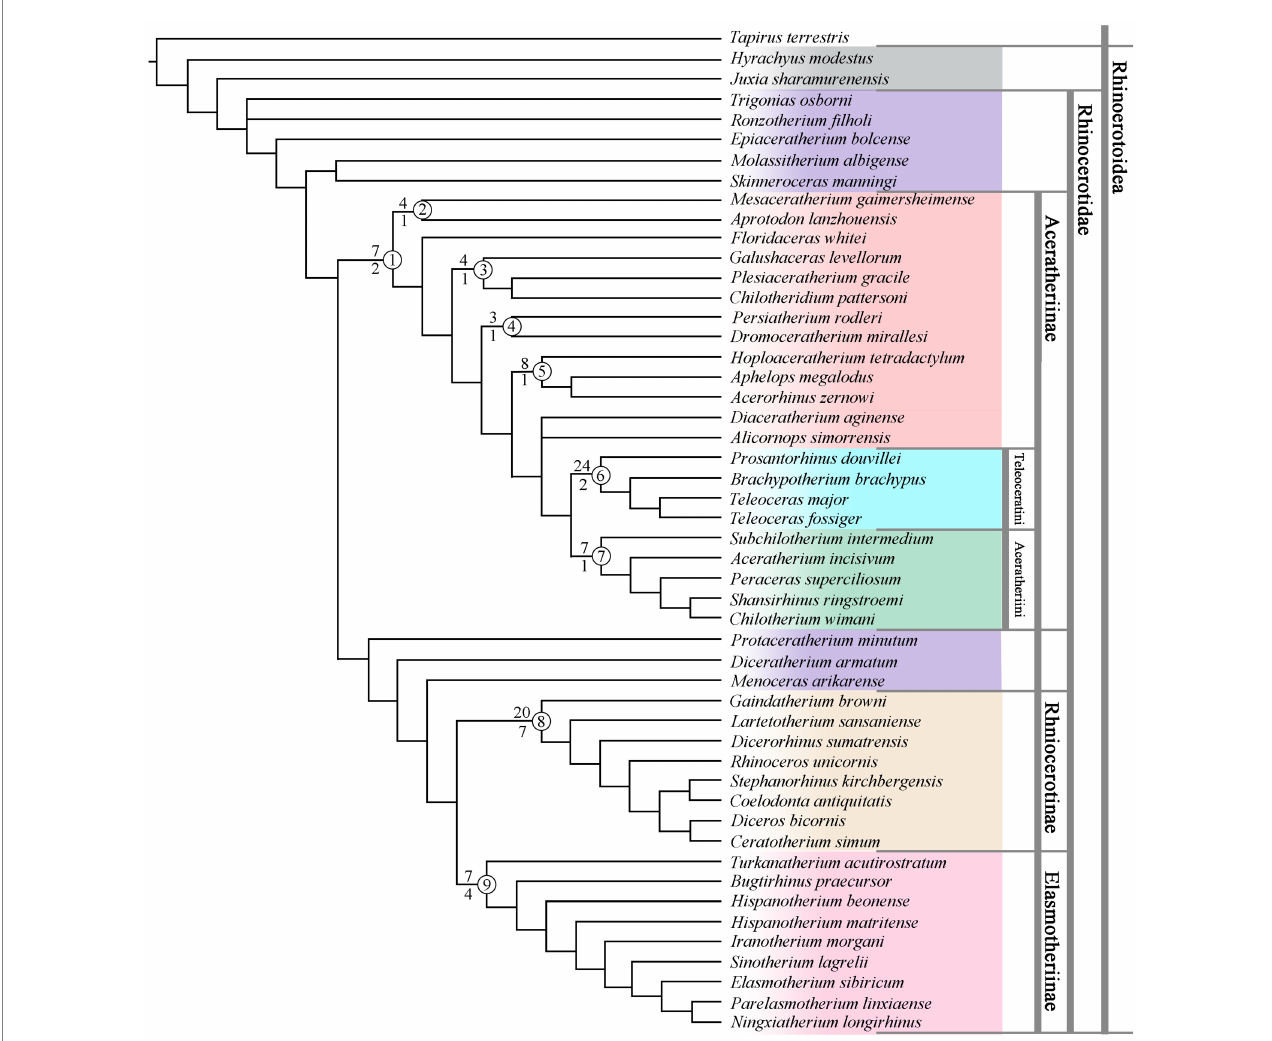
FIGURE 1 Consensus tree of the three most parsimonious trees with 98 characters ordered. Numbers above nodes are counts of synapomorphies and below nodes are Bremer support values. Colored areas and labeled thick lines on the right side indicate phylogeny